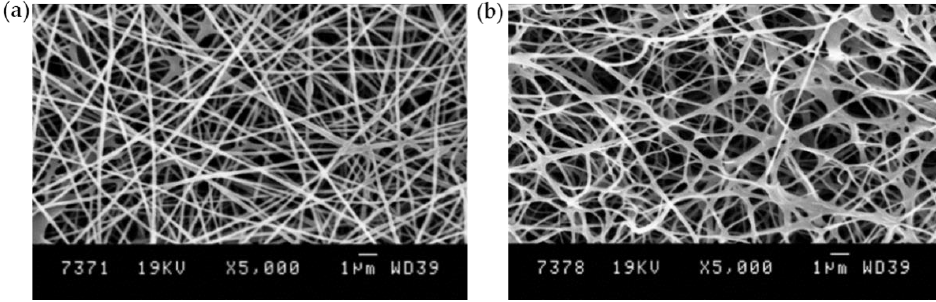
Figure 2. ESEM images of electrospun fibers from a two component solution of the chitosan (4.4 wt% CsU1) and PEO (60:40 ratio) (CN14, Table 2) ( a ) before and ( b ) after stabilization and PEO removal.